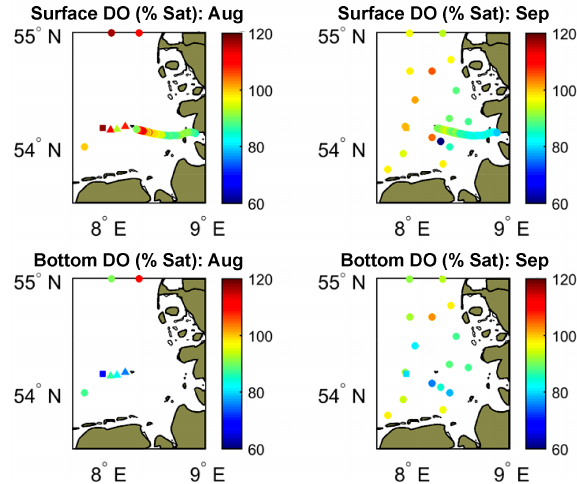
Figure 14. Dissolved oxygen (% saturation) in surface and bot- tom waters measured in August and September 2013. The surface and bottom dissolved oxygen were measured at available discrete stations from AWI and BSH stations, along with FerryBox (M/V Funny Girl ) and Deutsche Bucht MARNET station. The dates of coverage are listed in Table